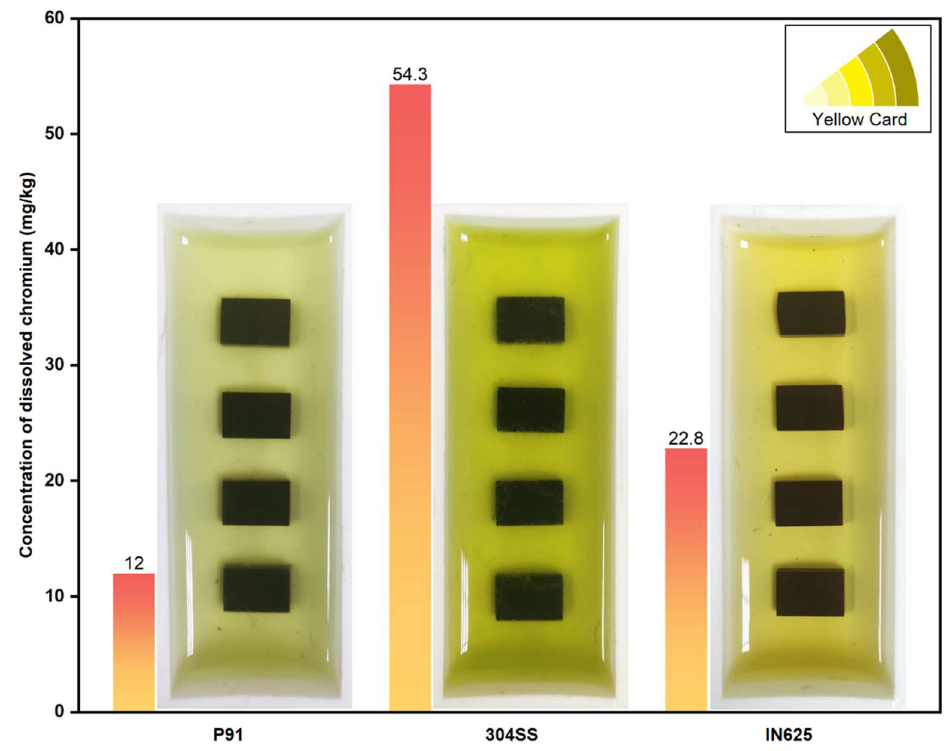
Figure 9. Salt samples and corresponding chromium concentration after 15 days of corrosion test for P91, 304SS, and IN625 alloys.